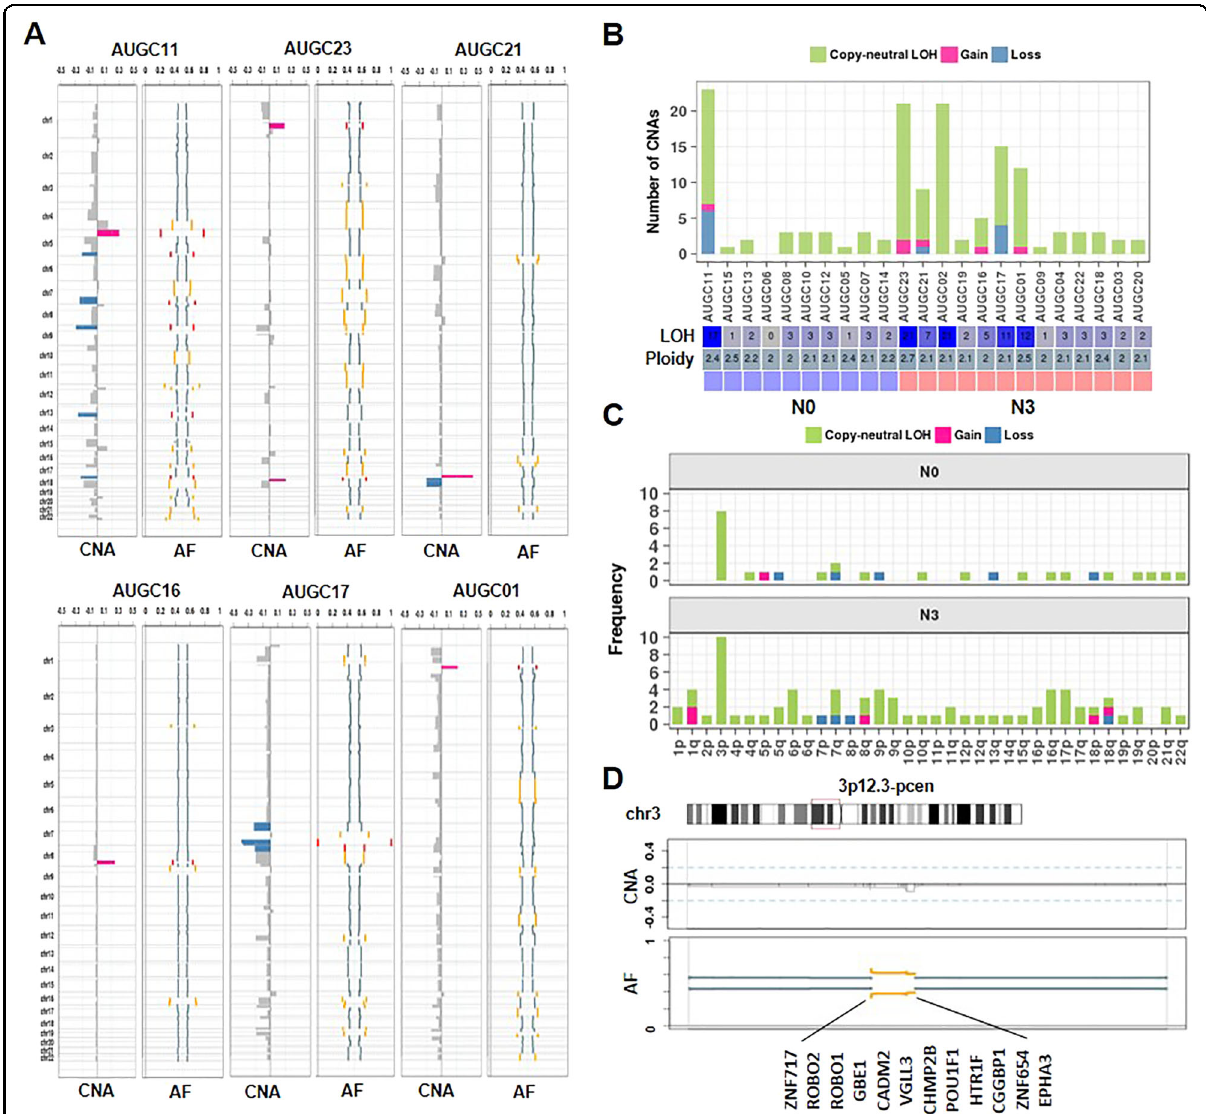
Fig. 5 DNA copy number aberrations in DGC. a Chromosomal views show the DNA copy number aberration (CNA) and allele frequency (AF) of each tumor. Copy number gains (red) and losses (blue) are shown in chromosomal CNA views (left). Copy-neutral LOH (orange) and LOH with gains or losses (red) are shown (right). b A bar plot showing the frequency of CNAs in each DGC tumor (top). Copy number gains (red), losses (blue) and copy-neutral LOHs (green) are shown. A heatmap showing relative numbers of LOHs and the ploidy of each tumor (bottom). c Bar plots showing the frequency of CNAs across chromosome arms in N0 (top) and N3 (bottom) tumors. d A plot showing copy-neutral LOHs (orange) at the 3p12-pcen region and the 12 genes within this